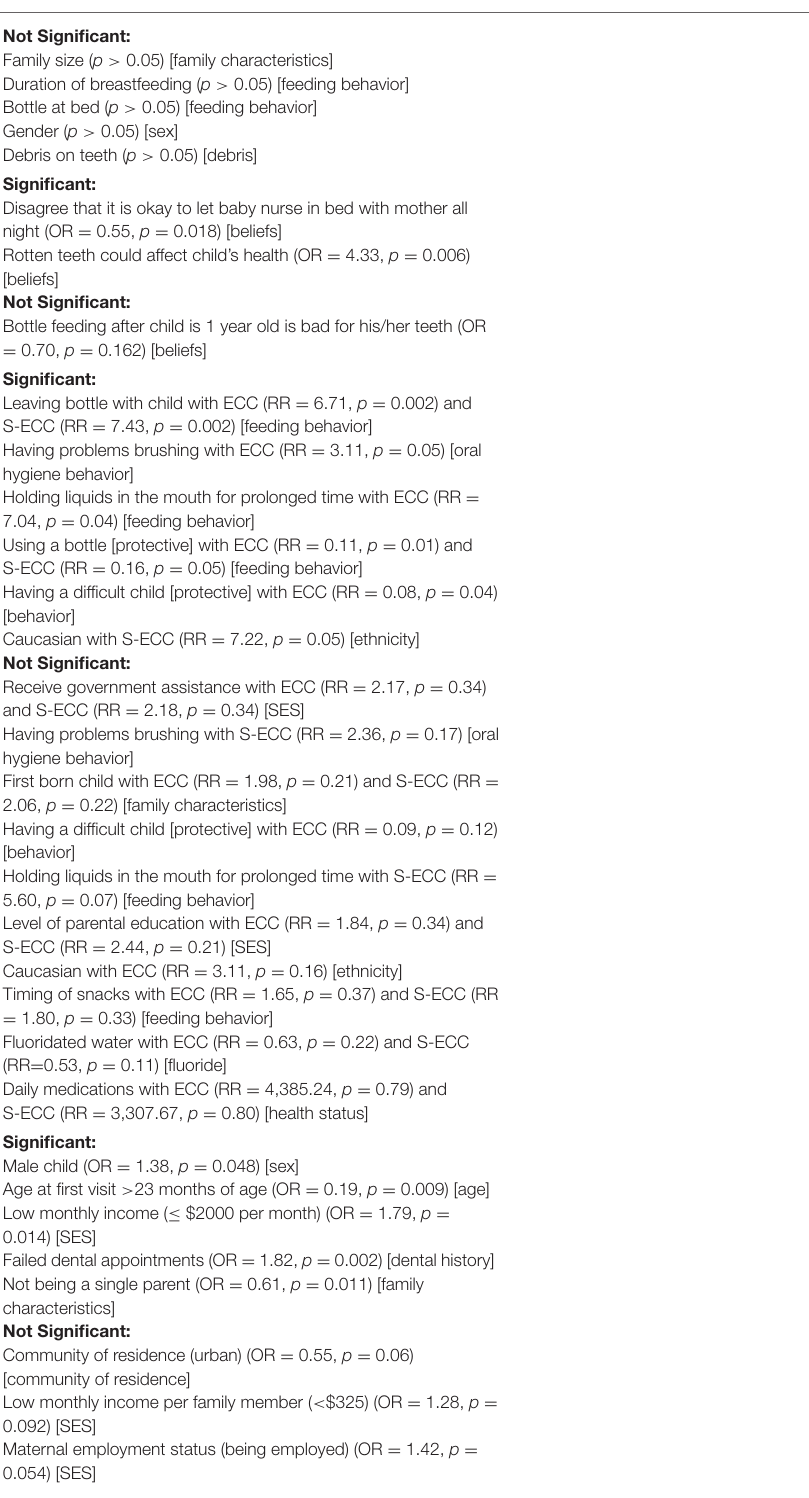
TABLE 2 | Identified risk factors for ECC in Canadian studies. Study Risk factors for ECC or S-ECC from multiple logistic Schroth and Moffatt